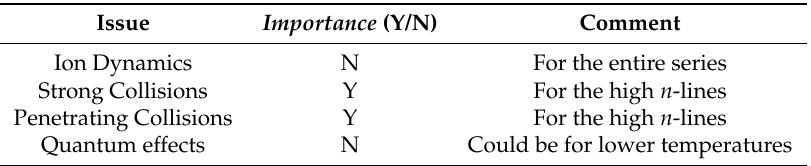
Table 1. Line broadening issues and their importance for line